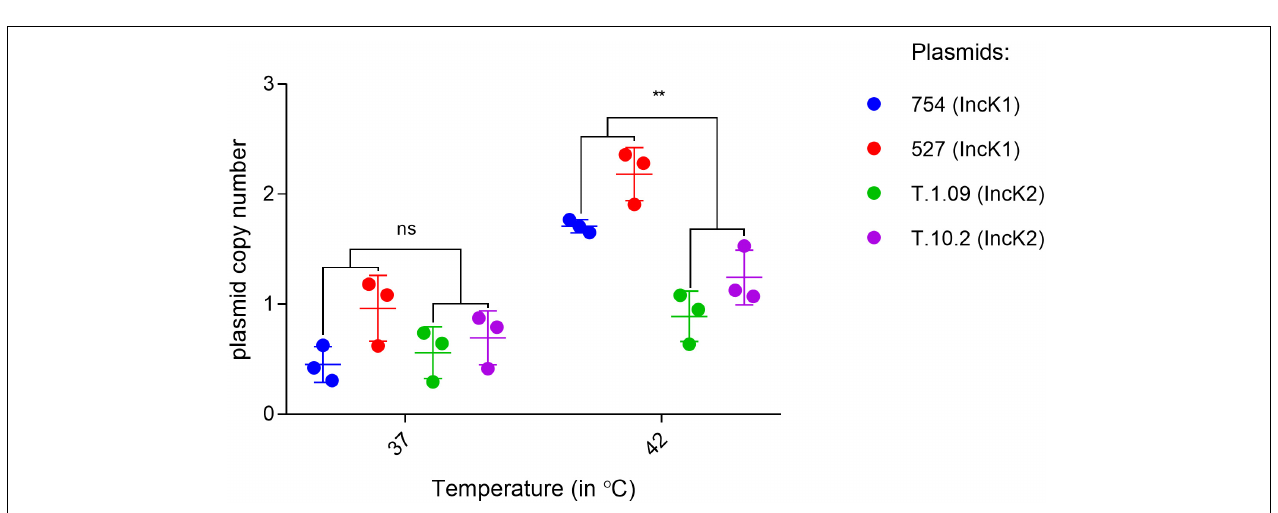
FIGURE 1 | Triplicate measures of conjugation rates of IncK plasmids at 37 and 42 ◦ C. Bars depict the mean and standard deviation. ∗∗ depict statistical significance ( p = 0.0039).